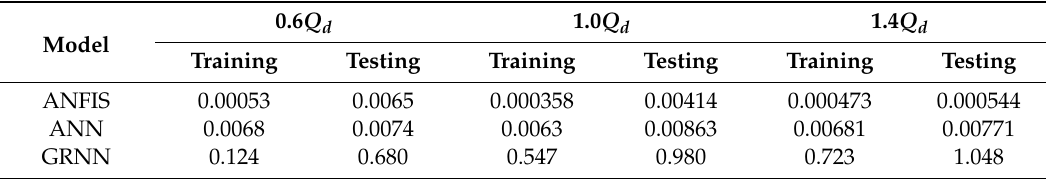
Table 12. Root mean square of error (RMSE) comparison for ANFIS, ANN, and